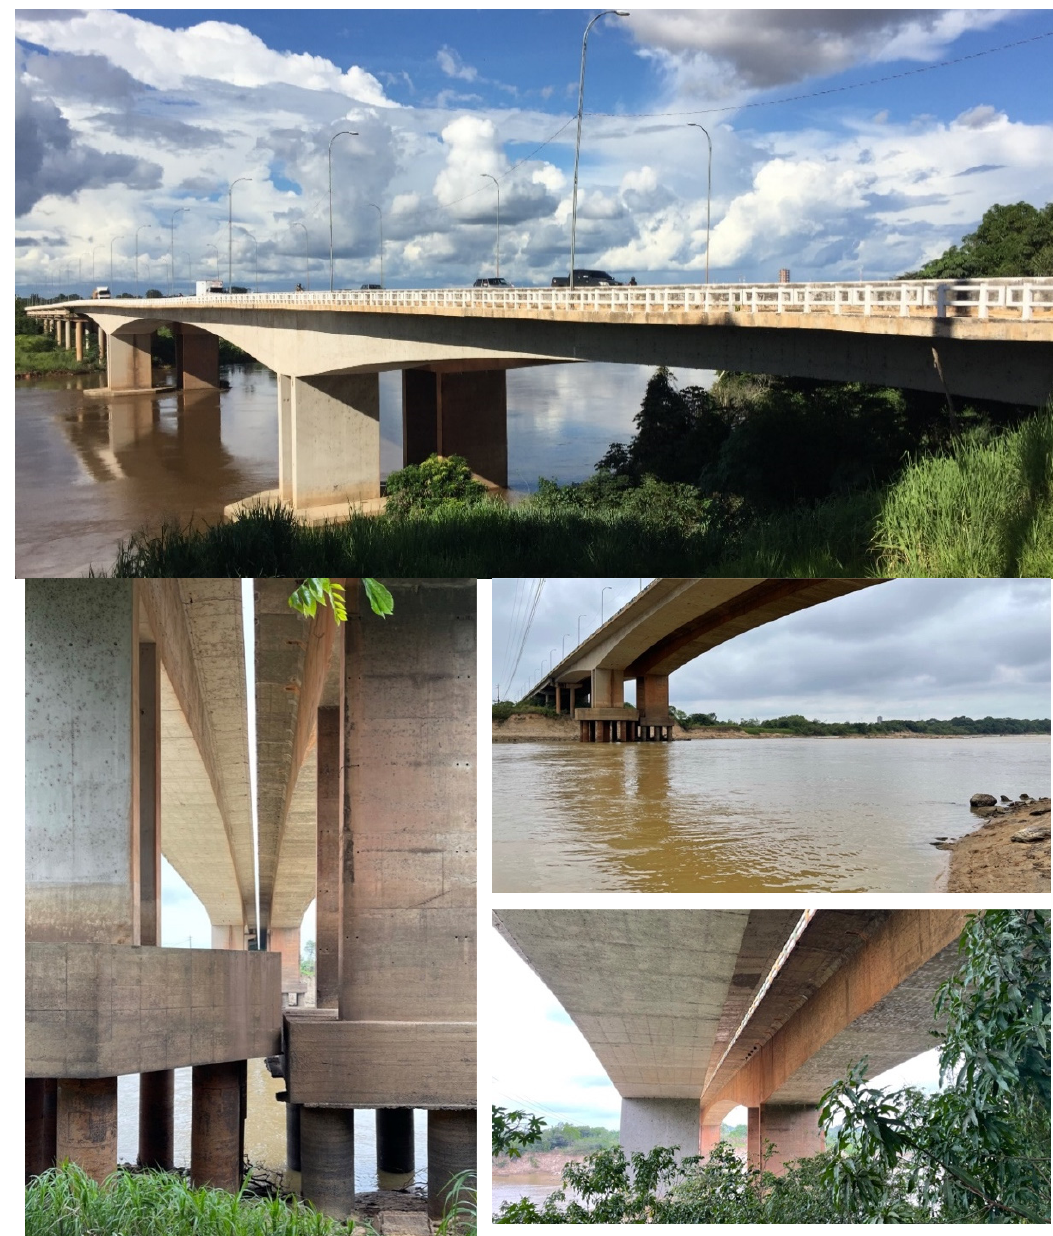
Figure 15. New (left) and old (right) bridges over the Itacaiúnas River. Figure 15. New ( left ) and old ( right ) bridges over the Itacai ú nas River.